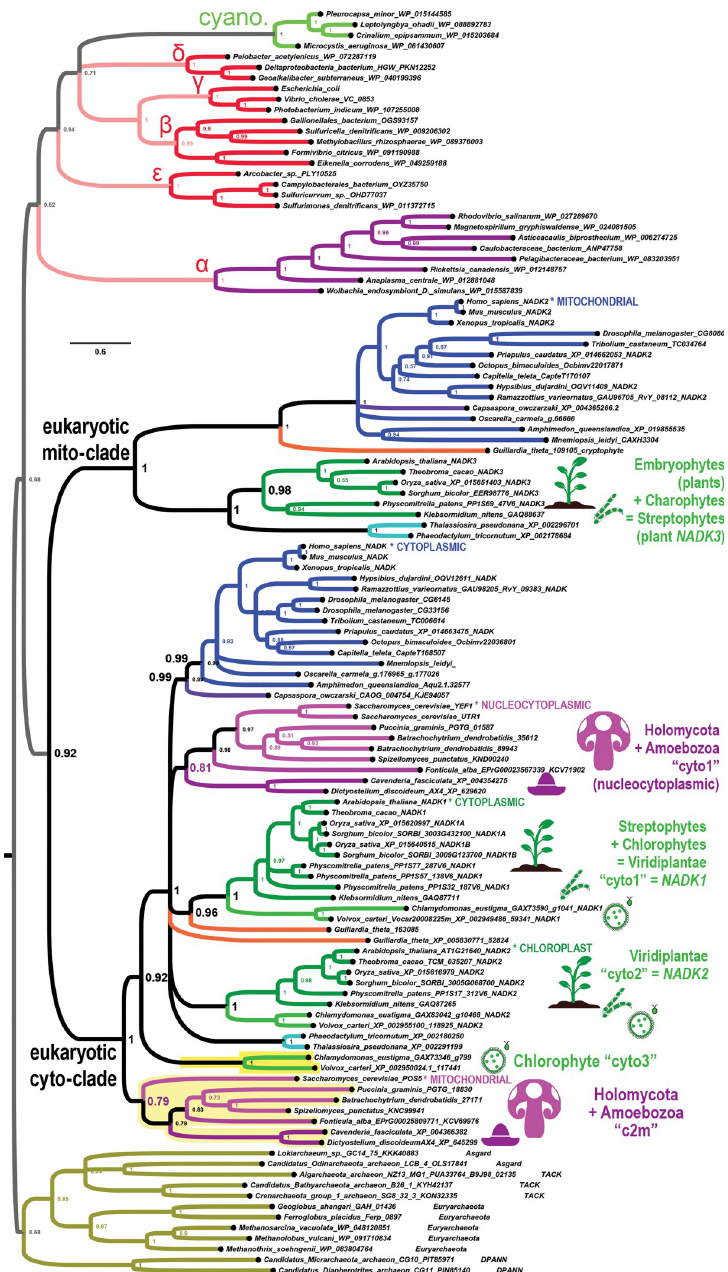
Fig 2. Fungi and Chlorophytes have lost mito-clade NADK genes while independently duplicating a cyto-clade gene. Plants (embryophytes), charophytes, and chlorophytes are each depicted with green icons, while Holomycota (fungi + Fonticula alba ) and amoebozoans are each depicted with purplish pink icons. A pair each of the fungal groups of ascomycetes, basidiomycetes, and chytridiomycetes were chosen to represent the fungi. The extra cyto-clades for Holomycota + Amoebozoa and for chlorophytes are highlighted in yellow and are found at the bottom of the eukaryotic